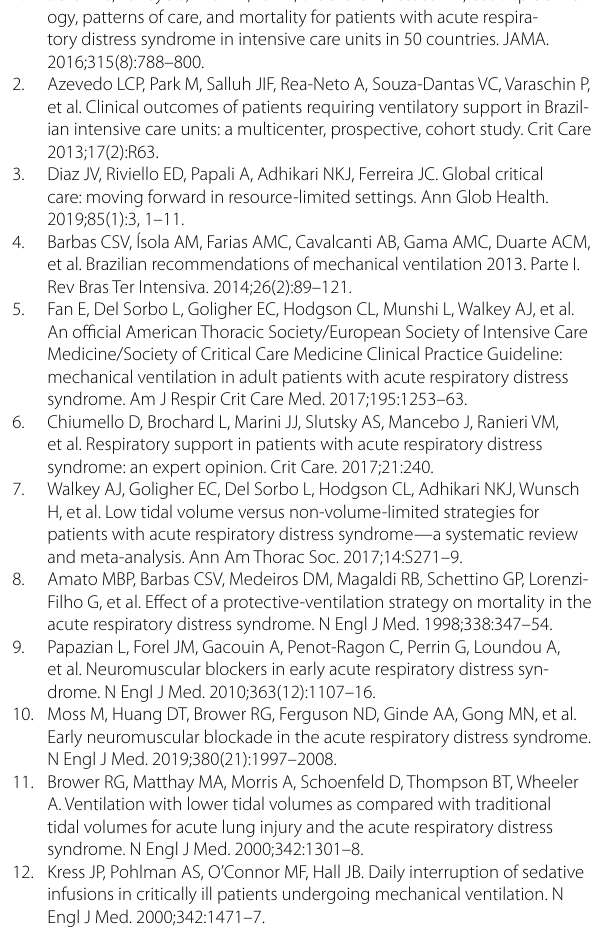
Additional file 1: Table S1. Comparison of blood gases between con‑ trolled ventilation and NAVA at the end of 3